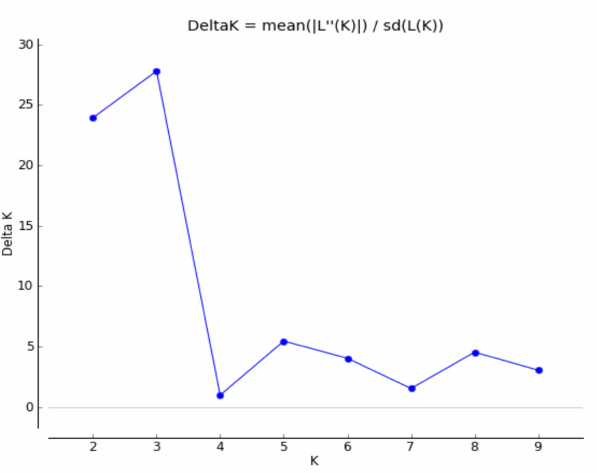
Figure 2. Estimation of the optimum number of clusters for the Apulian almond population according to Evanno’s method. For each K value, the DeltaK is reported, thus indicating that K = 3 is the uppermost probable number of genetically homogenous groups in the collection